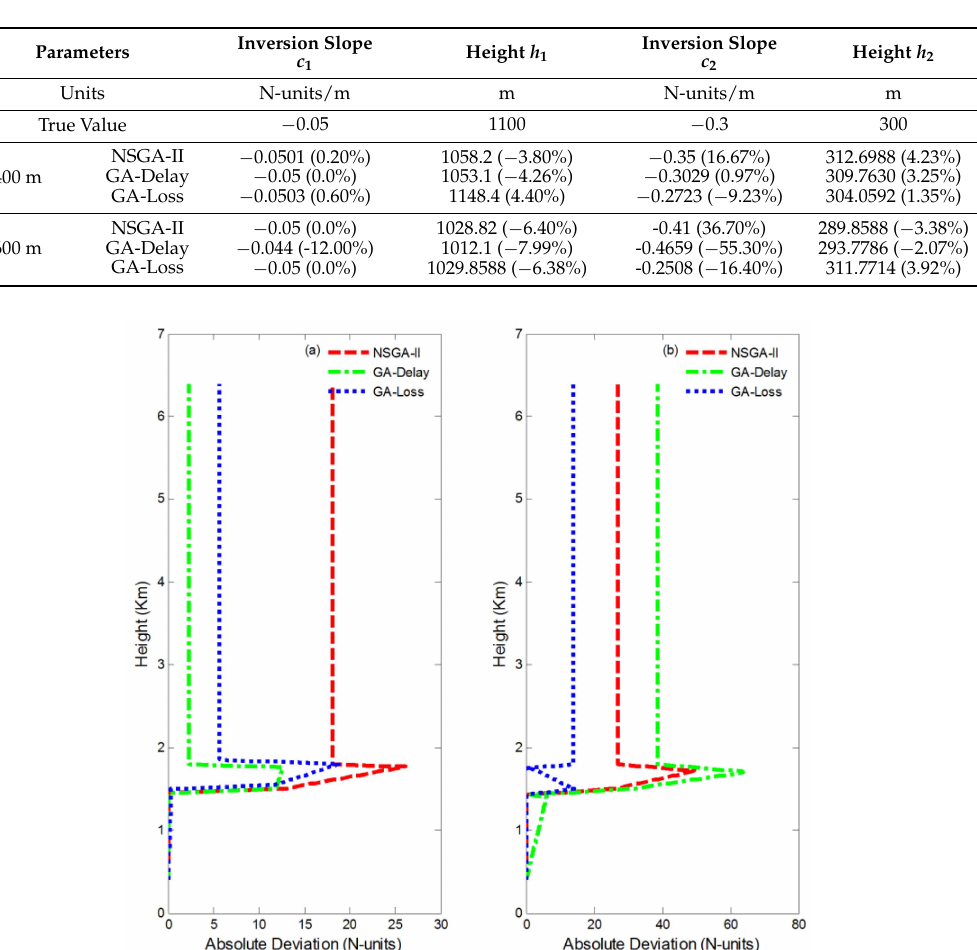
Figure 5. Refractivity absolute deviation under different antenna height: ( a ) 400 m antenna height. ( b ) 600 m antenna